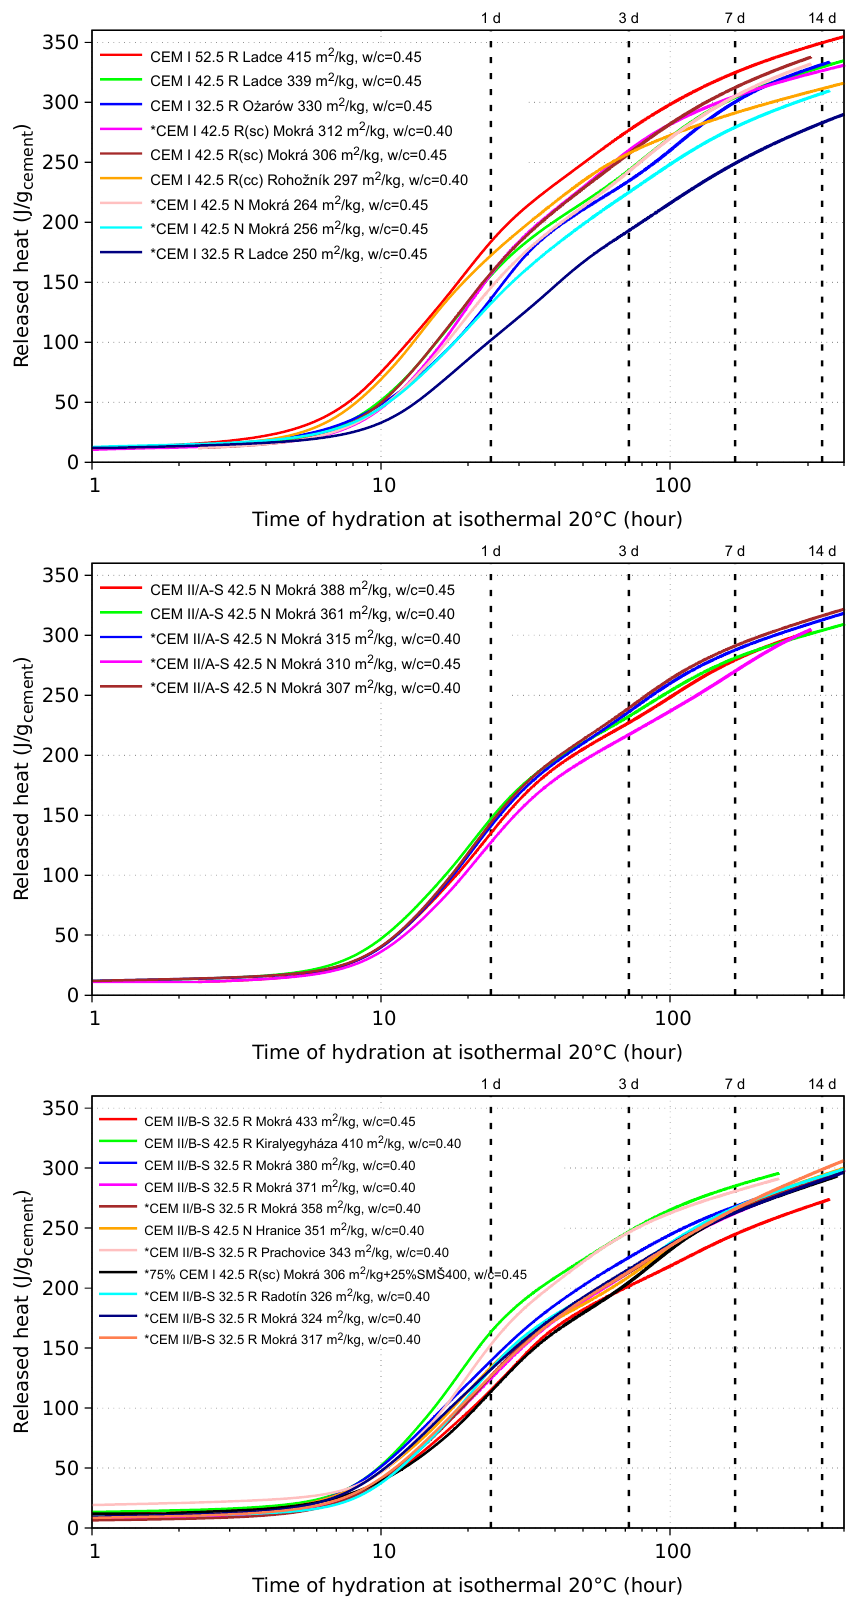
Figure 6. Released heat from isothermal calorimetry on 25 cements from groups CEM I, CEM II/A-S and CEM II/B-S. An asterisk signalizes a crack-resistant